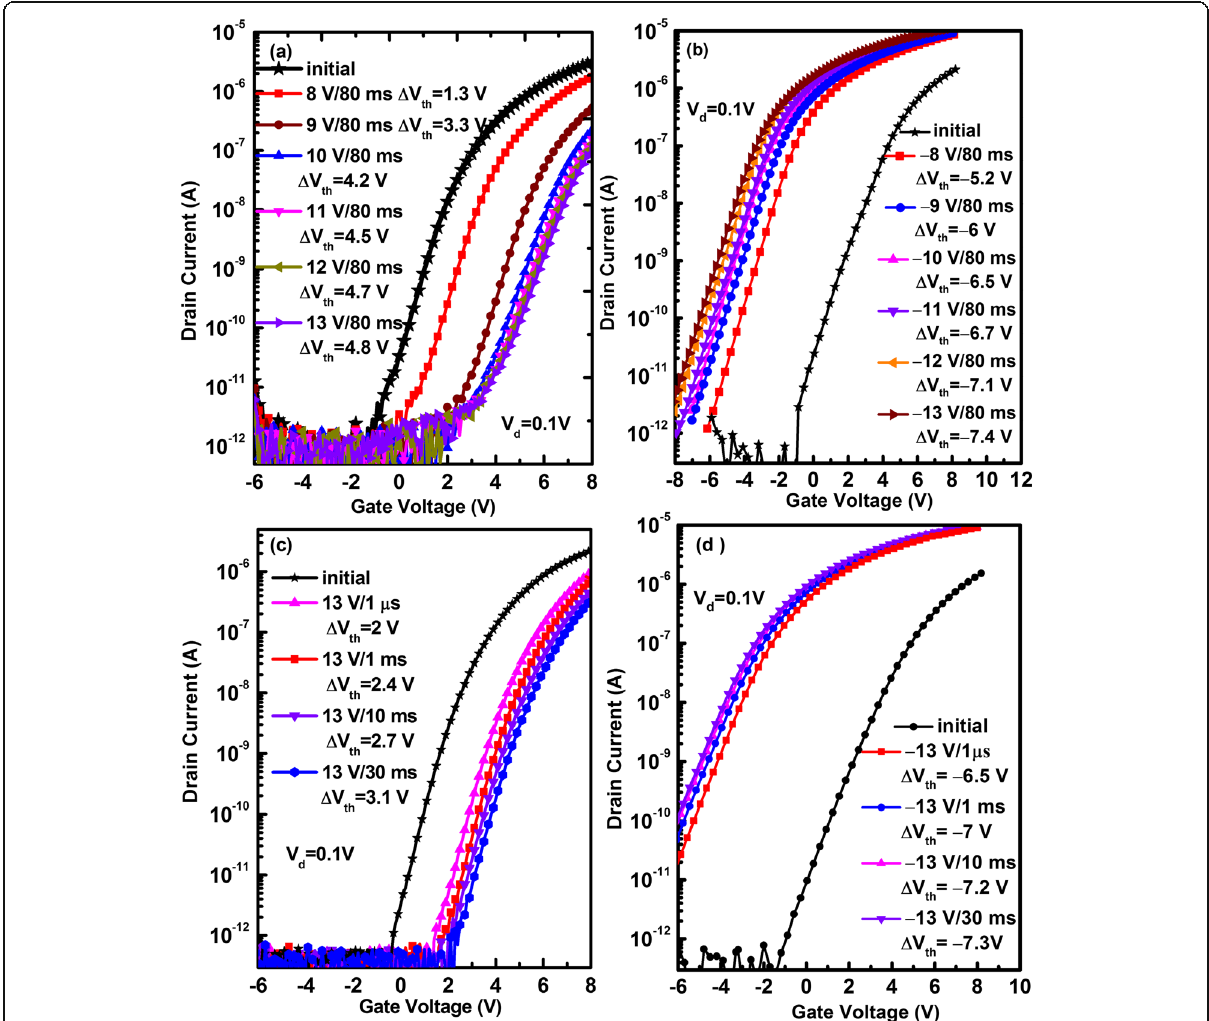
Fig. 2 The transfer curves of the a-IGZO TFT memory device and those programmed a at various positive gate biases for a constant time of 80 ms, b at various negative gate biases for a constant time of 80 ms, c at 13 V for various programming time, and d at − 13 V for various programming time. All the transfer curves for each figure were measured on the same device, and all programming operations were carried out in